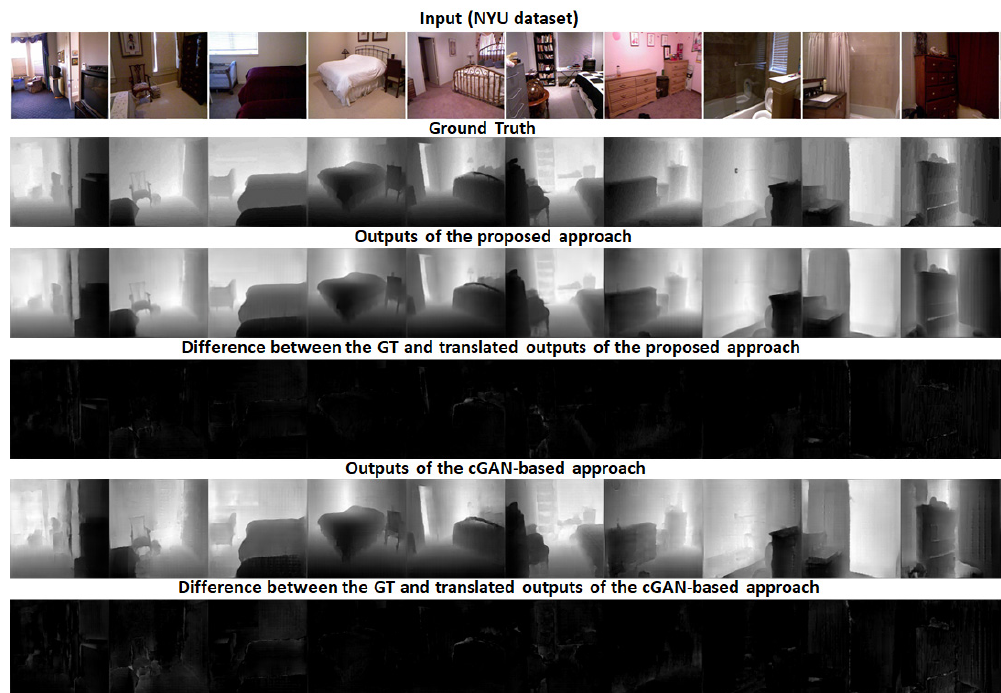
Figure 2. Input test samples in domain x are translated to domain y samples by the proposed approach and the cGAN-based approach [10]. The difference between the ground truth and generated images of the proposed approach and the cGAN-based approach are compared.